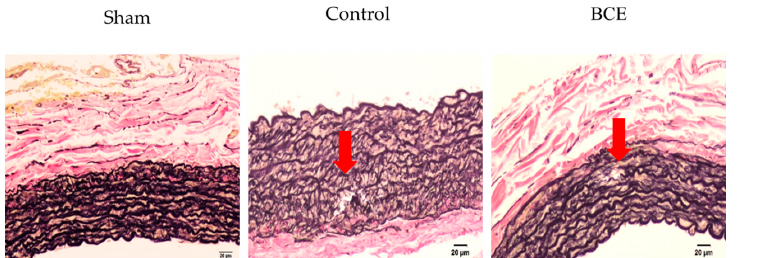
Figure 2. Representative images of elastin breaks in Elastica van Gieson stained tissues (200× magnification, scale bar = 20 μ m). Arrows indicate elastin breaks. No elastin breaks were observed in Sham rats. Sham, sham surgery rats; Control, OVX rats without BCE treatment; BCE, OVX rats treated with 3% BCE; OVX, ovariectomized; BCE, blackcurrant ( Ribes nigrum L.) extract. Since no elastin breaks were observed in Sham rats, we evaluated elastin breaks in OVX Control rats and OVX BCE rats. The elastin break positivity rate was reduced in OVX BCE rats (21.4%) compared with that in OVX Control rats (35%) (Table 1). Table 1. Elastin break positivity rate expressed as a percentage. Sham OVX Control OVX BCE Number of elastin break-positive specimens 0 7 3 Total number of specimens 10 20 14 Number of elastin break-positive specimens/total 0 35.0 21.4 number of specimens (%) Table 2. Semi quantification in Number of elastin brakes per Elastin brake positive sections. OVX Control OVX BCE Number of elastin brakes 9 3 Elastin brake positive sections 7 3 Number of elastin brakes/Elastin positive sections 1.3 1.0 SD 0.5